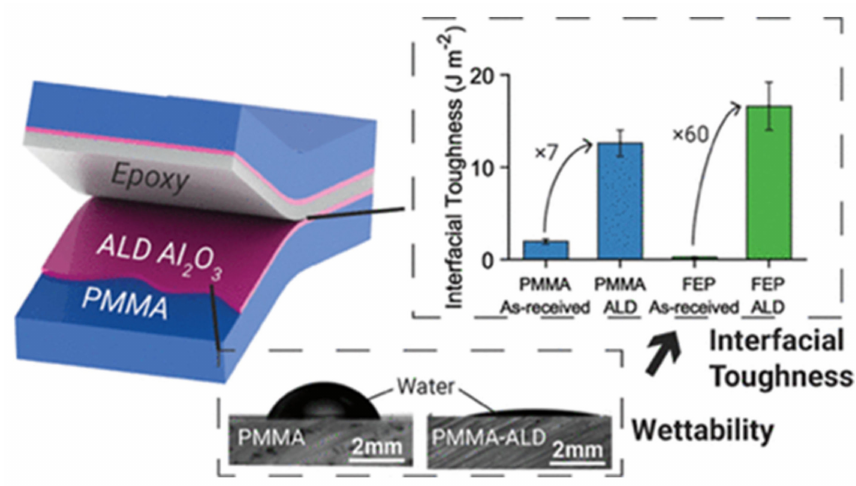
Figure 8. Thermoplastic-epoxy resin with the double Al 2 O 3 coating; wettability test of a water droplet in coated and uncoated PMMA surface, and the interfacial toughness of PMMA and fluorinated ethylene propylene (FED) (wedge test) (reprinted with permission from [54], Copyright (2019), American Chemical